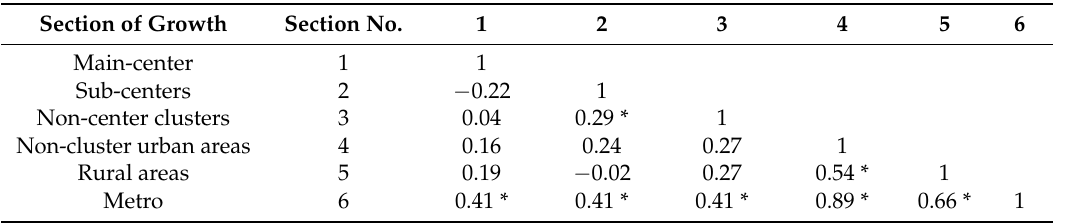
Table 4. Correlation matrix for growth in five submetro sections for large metros. Section of